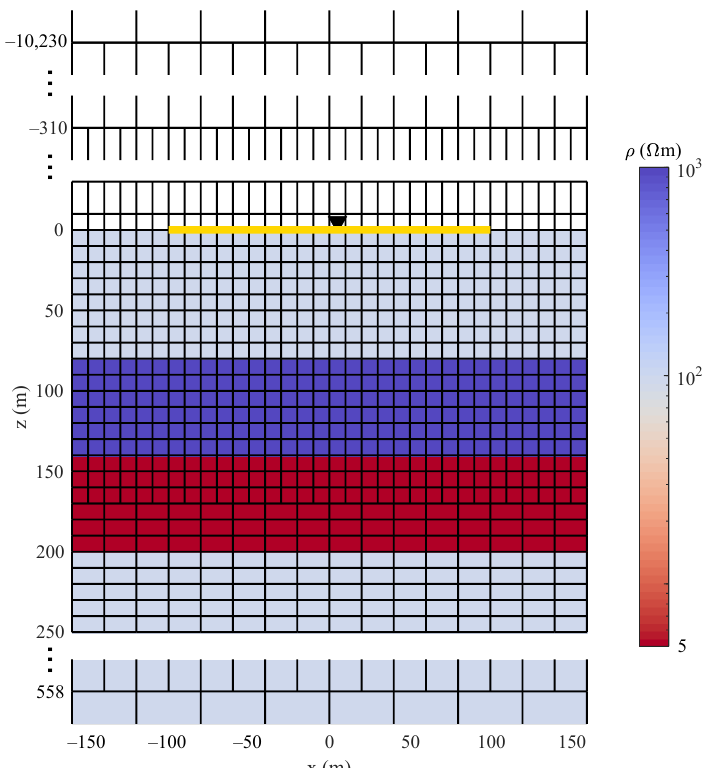
Figure 3. Example 1: model, measurement configuration, and MR grid discretization (central region). Yellow line and black cone denote loop source and observation site, respectively. Air resistivity (10 6 Ω m) is not shown with